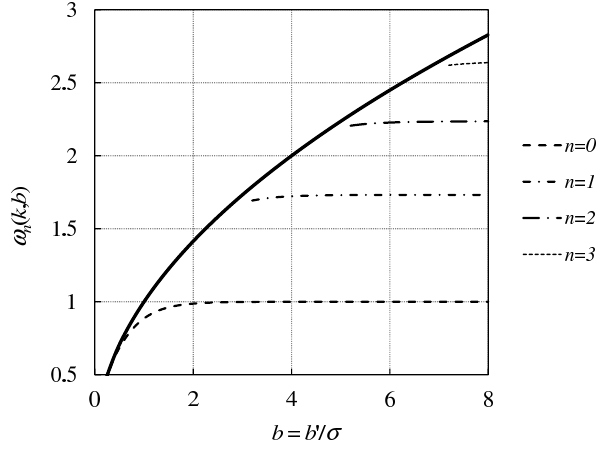
Fig. 11. Behaviour of the first eigenvalues ω n , n = 0 , 1 , 2 , 3, versus b for k = 1. The bold line represents the upper limit ω = k domain Eq.